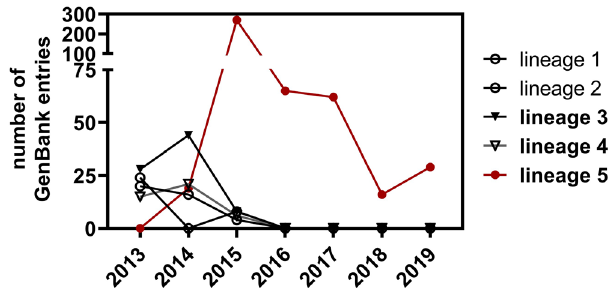
Fig. 1 MERS-CoV sequences uploaded to NCBI GenBank between 2013 and 2020. All available GenBank entries for MERS-CoV with a sequence length ≥ 28,000 nucleotides ( n = 537) nucleotides were included, as well as concatemerized sequences with sequence length ≥ 5,000 nucleotides 19 n = 24. The collection date provided in GenBank was used for assigning a year to each sequence. No sequences were found with a collection date later than